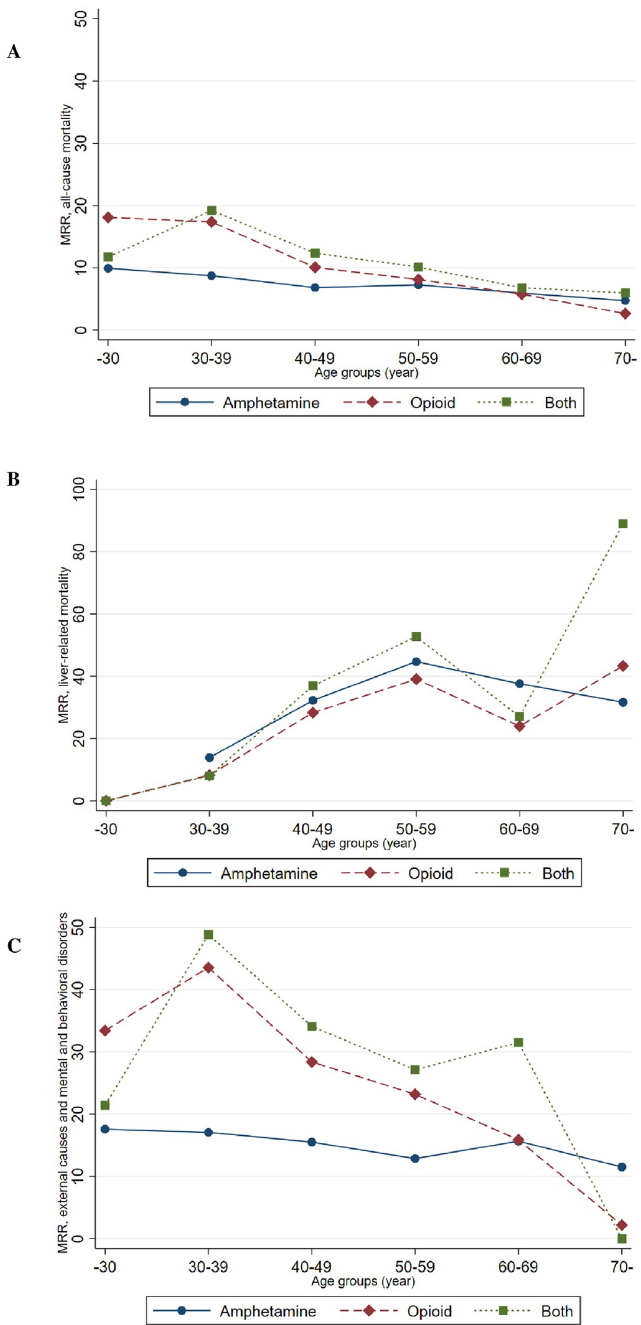
Fig 2. Mortality rate ratio. Hepatitis C virus-infected people who inject drugs compared with matched controls without hepatitis C diagnosis from the general population. (A) All-cause mortality, (B) liver-related mortality, (C) death from external causes and mental and behavioral